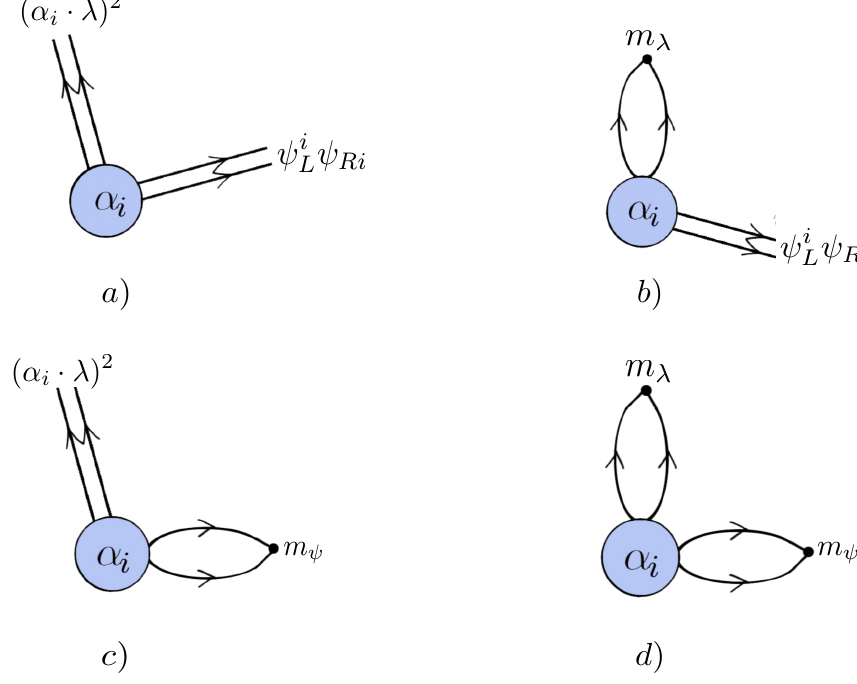
twisted boundary conditions Figure 10 . a)Monopole operators in N f = N c QCD(F/adj) with Ω 0 F b) with soft m . c)with soft m d) with soft m and m . In the limits where either of the λ ψ λ ψ